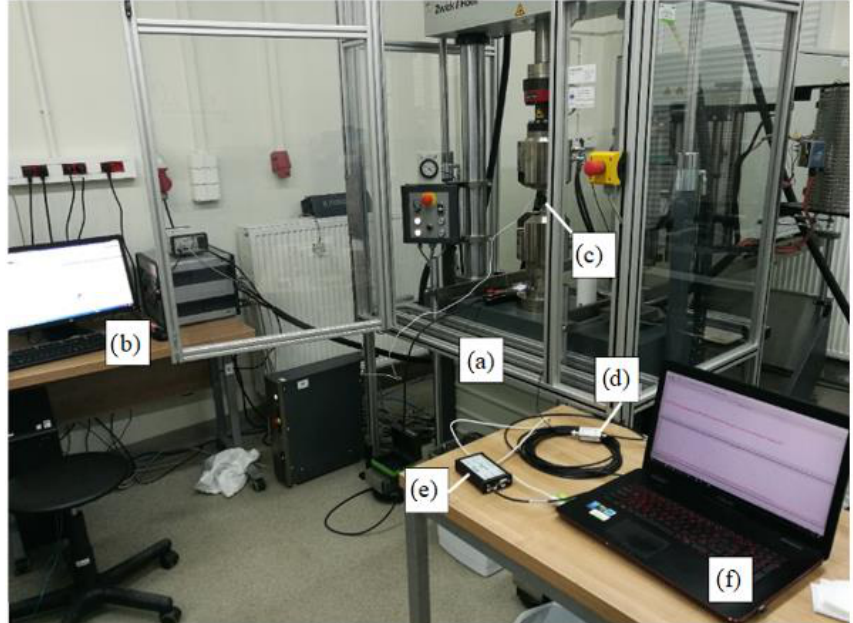
Figure 3. General view of the laboratory stand: ( a ) tensile stress machine, ( b ) tensile stress machine computer, ( c ) AE sensor, ( d ) preamplifier, ( e ) AE recorder, ( f ) AE computer.